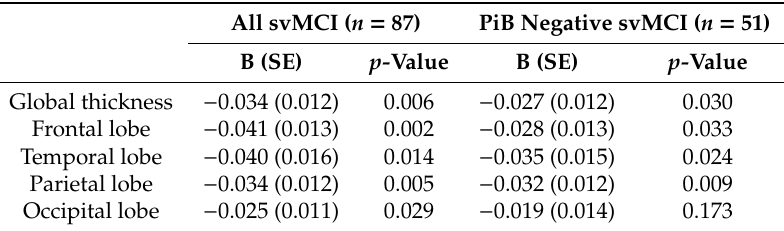
Table2. Longitudinalchangeofcorticalthicknessinthewhitematterhyperintensity(WMH)progression group compared with the WMH regression